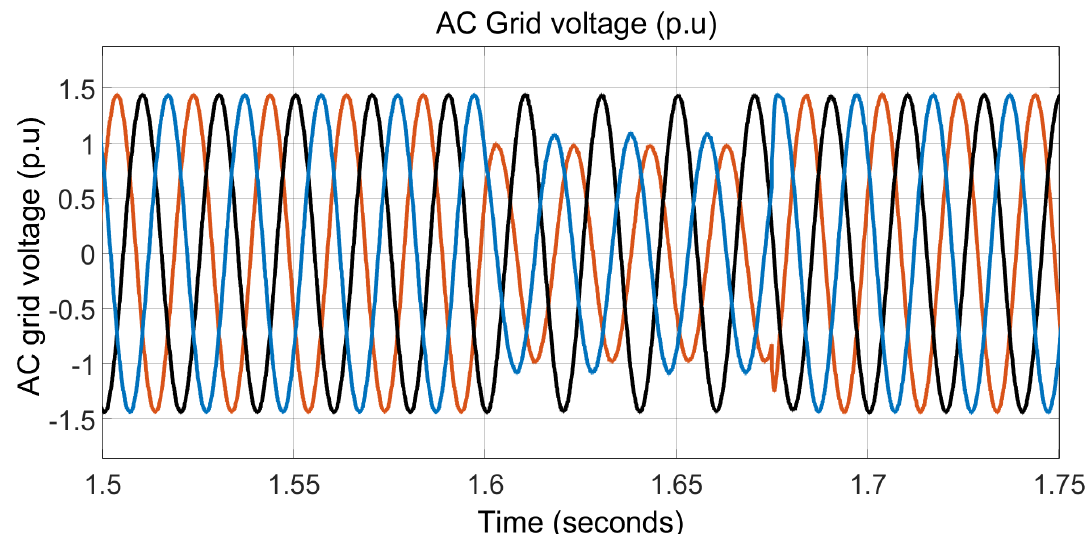
Figure 20. Upstream AC grid voltage sag of − 60%